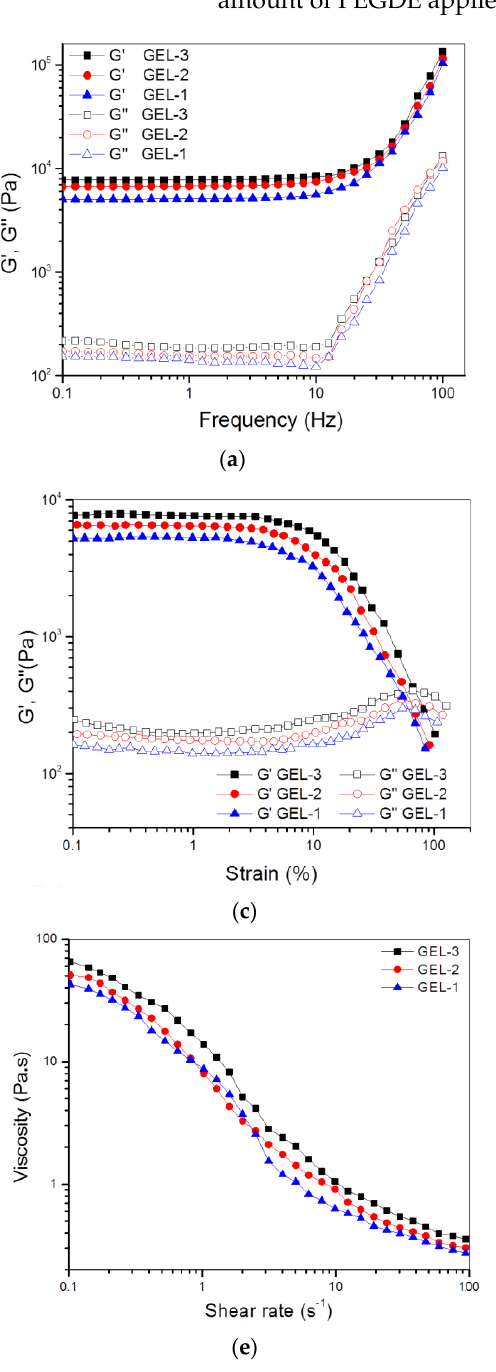
Figure 6. Frequency-dependent functions ( a ) of G ′ and G ″ , average values ( b ) of G′ and G″ at 1 Hz, variations ( c ) in G ′ and G ″ versus strain, average yielding strain ( d ) and shear rate dependency ( e ) of viscosity (C, 25 °C) for gels illustrated in Table 3 ( * , p < 0.05; ** , p < 0.01; N.S., not significant). Table 3. Parameters for dual-crosslinked hydrogels.